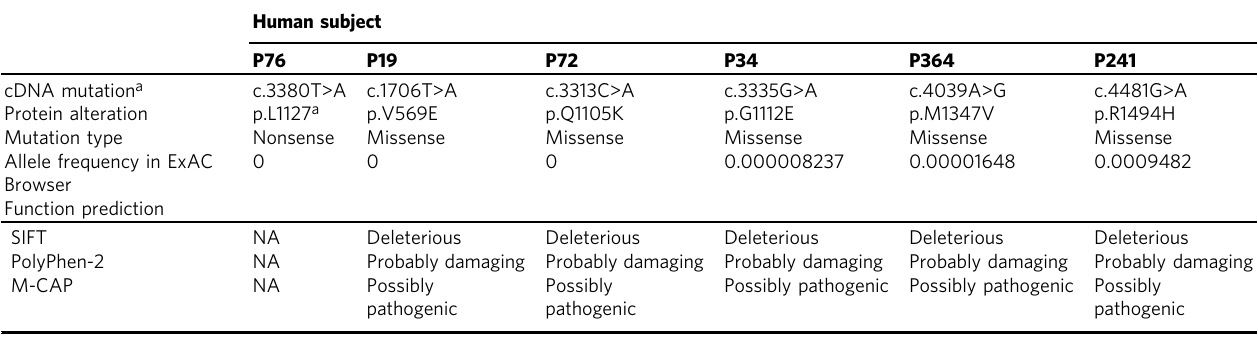
Fig. 7 The mechanisms were elucidated by proposed models. a The mechanisms of QRICH2 modulating the development of sperm fl agella. QRICH2 promoted sperm fl agellar formation through upregulating ODF2 and CABYR expression as a transcription factor, inhibiting ubiquitin-mediated degradation of AKAP3, TSSK4, and ROPN1 and fi nally reinforcing the interaction of AKAP3/CABYR/ROPN1 and TSSK4/ODF2 during the biogenesis of sperm fl agella. b – d Effects of QRICH2 mutations on the structural conformation of QRICH2 protein. Superimposed structures of wild type (green) and mutant (purple) of QRICH2. The structures of QRICH2 protein were changed by the mutations of c.3313C>A [p.Q1105K] ( b ), c.3335G>A [p.G1112E] ( c ) and c.4039A>G [p.M1347V] ( d ). e The difference of the abnormal sperm tail number between WT mice and Ht mice was not signi fi cant. (Student ’ s t -test; n = 3 biologically independent WT mice or Ht mice; NS not signi fi cant; error bars, s.e.m) Table 3 Analysis of QRICH2 mutations in asthenozoospermia